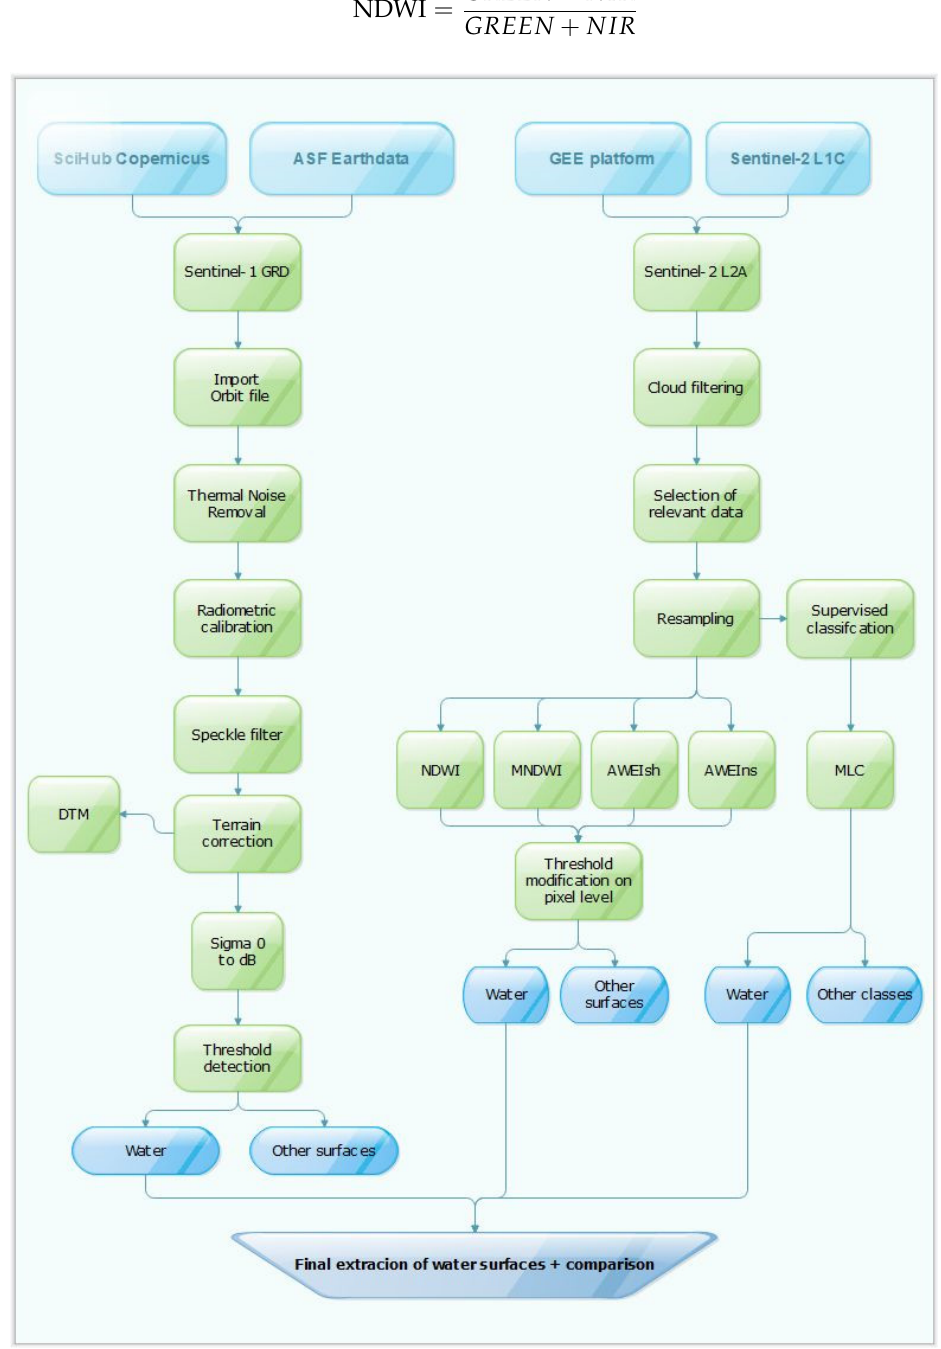
Figure 4. Water bodies extraction workflow, including data preparation, data processing, and results interpretation.